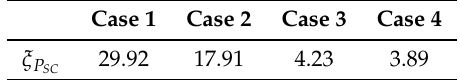
Table 6. The energy saving rate for different